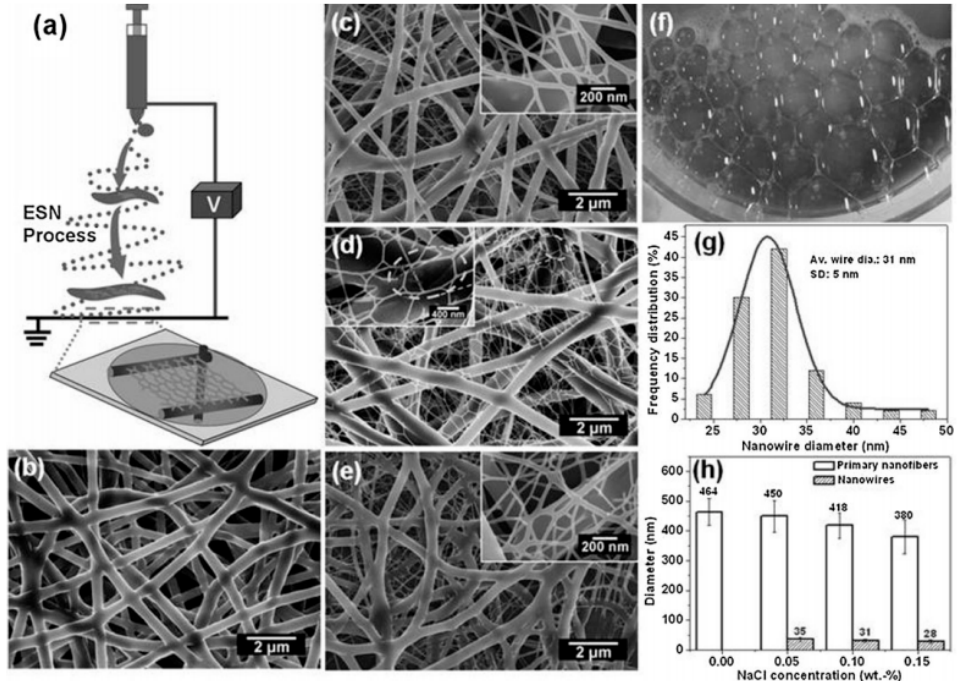
Figure 3. ( a ) Schematic diagrams illustrating the possible mechanism of PU-NF structure formation. FE-SEM images of PU/NaCl PU-NF membranes formed with a voltage of 30 kV and different NaCl concentrations: ( b ) 0 (pristine PU); ( c ) 0.05; ( d ) 0.1 and ( e ) 0.15 wt %; ( f ) Optical image of soap bubbles; ( g ) Histogram showing the nanowire diameter distribution of nano-nets presented in ( d ); ( h ) The effect of NaCl content on the diameter distribution of nanofiber and nanowire.